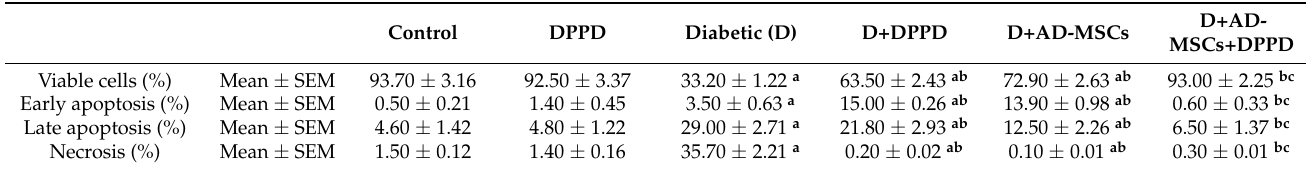
Table 2. Pancreatic annexin